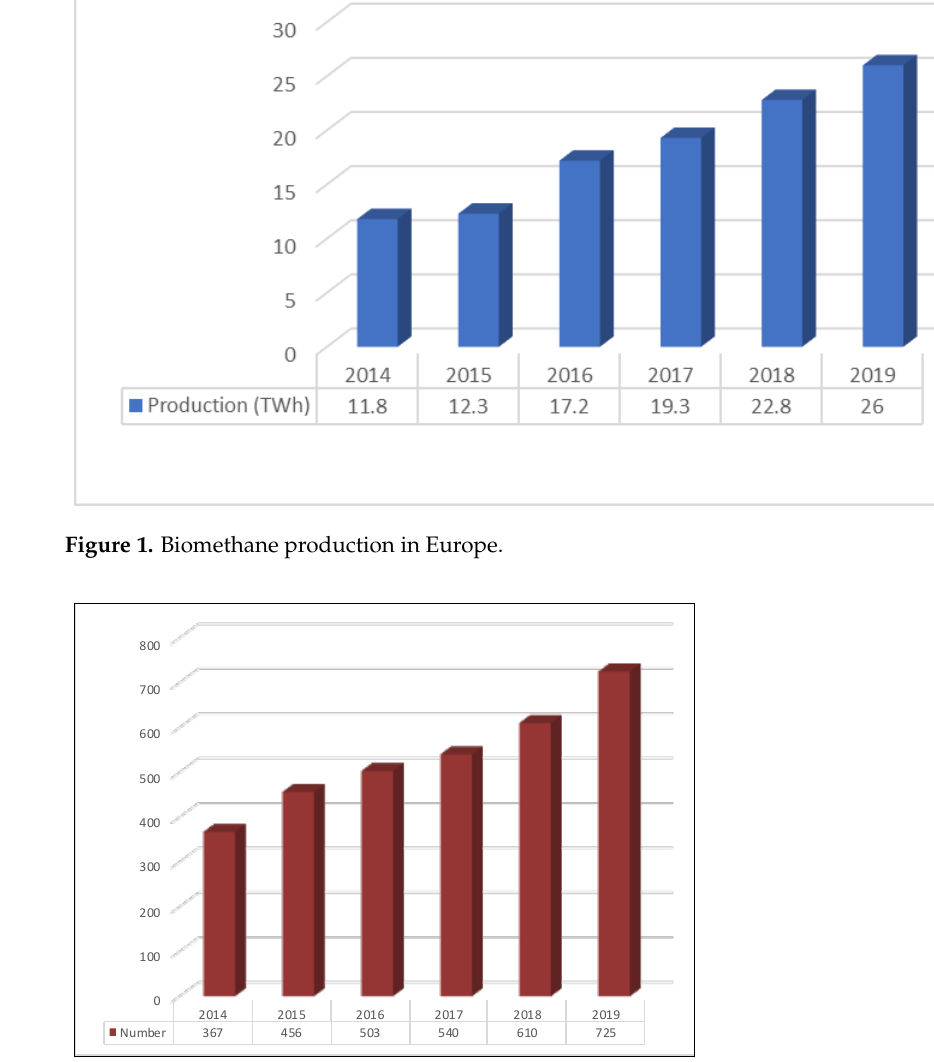
Figure 2 . Number of biomethane plants in Europe.